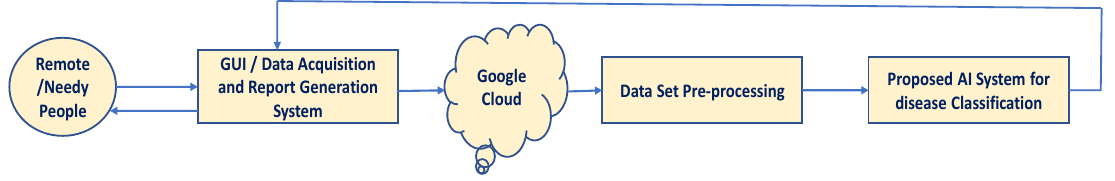
Figure 2. Architecture of Proposed IoMT Treatment Support System for COVID-19.